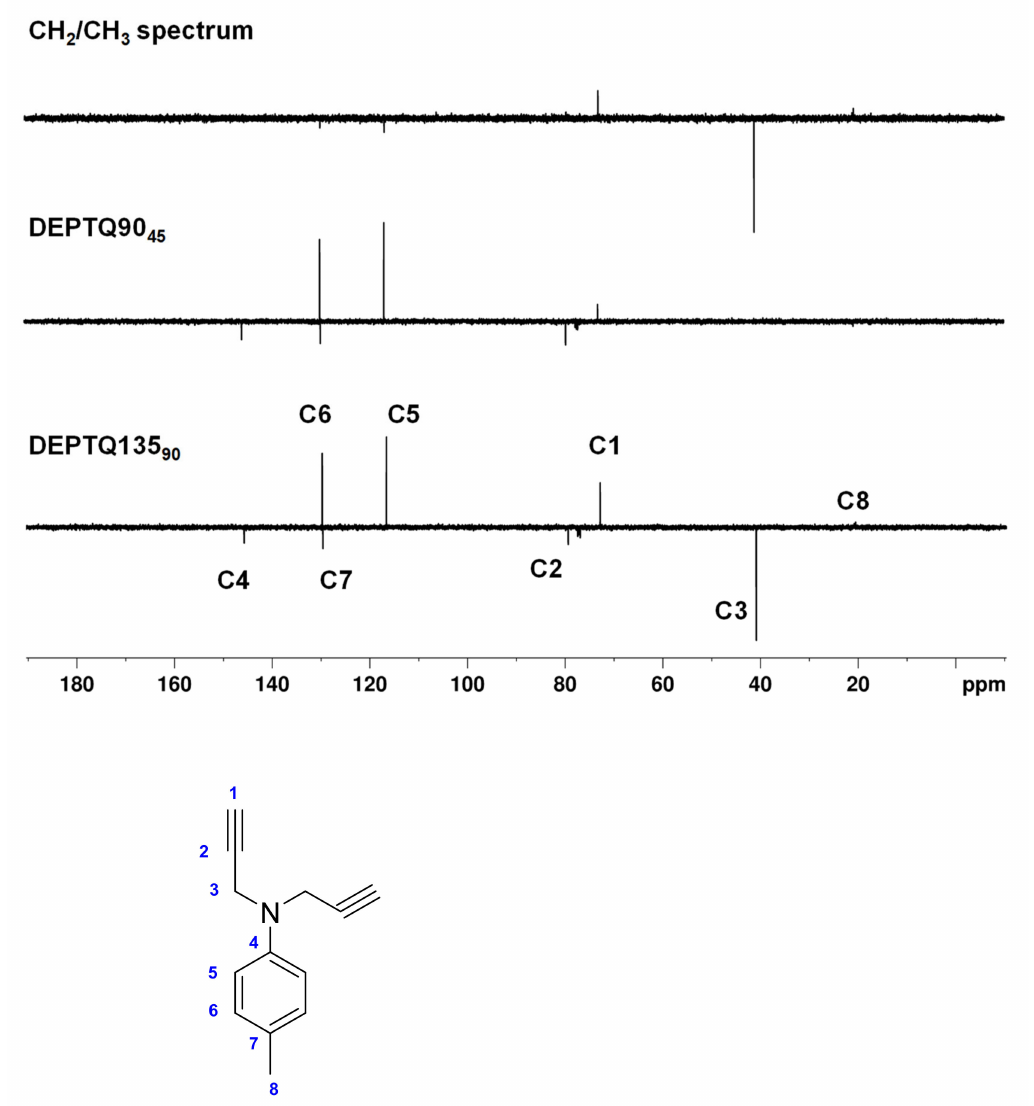
Figure 1. 4-methyl- N,N -di(prop-2-yn-1-yl)aniline and carbon numbering and DEPTQ135 90 , DEPTQ90 45 , and the difference between DEPTQ135 90 and DEPTQ90 45 spectra of ~30 mg of 4-methyl- N,N -di(prop-2-yn-1-yl)aniline dissolved in 0.7 mL CDCl 3 . The delay δ was set to 2.70 ms, adjusted for a coupling constant 1 J CH of 185 Hz. The relaxation delay was 2 s, the NOE building period 1 s. All other parameters are identical to those described in the Materials and Methods